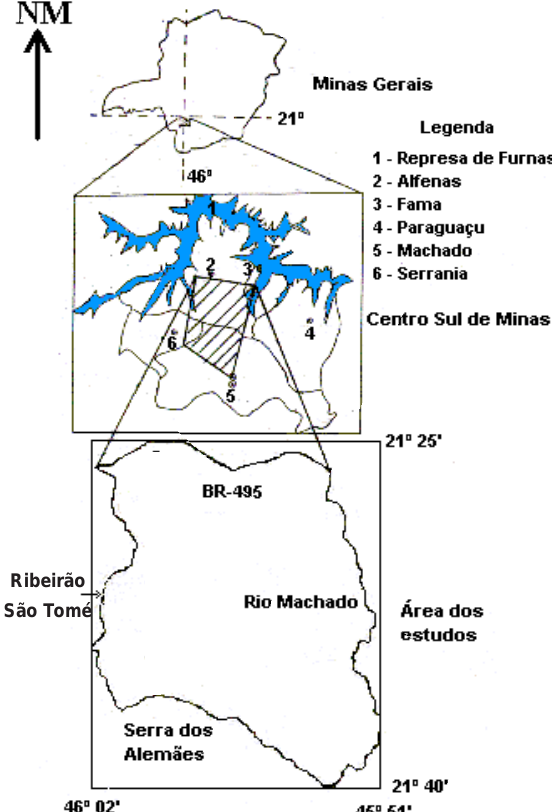
Figura 1. Localização da área de estudo.